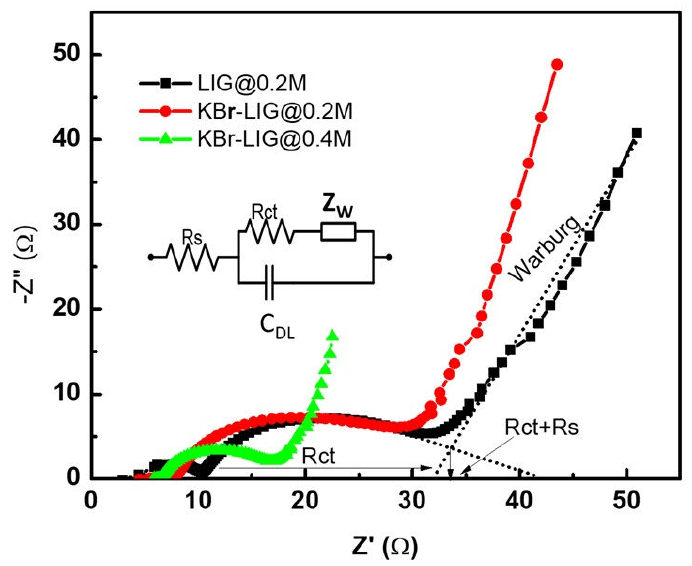
Figure 9. Nyquist plot and the equivalent EIS circuit (fitting by Zview software) for LIG@0.2M,